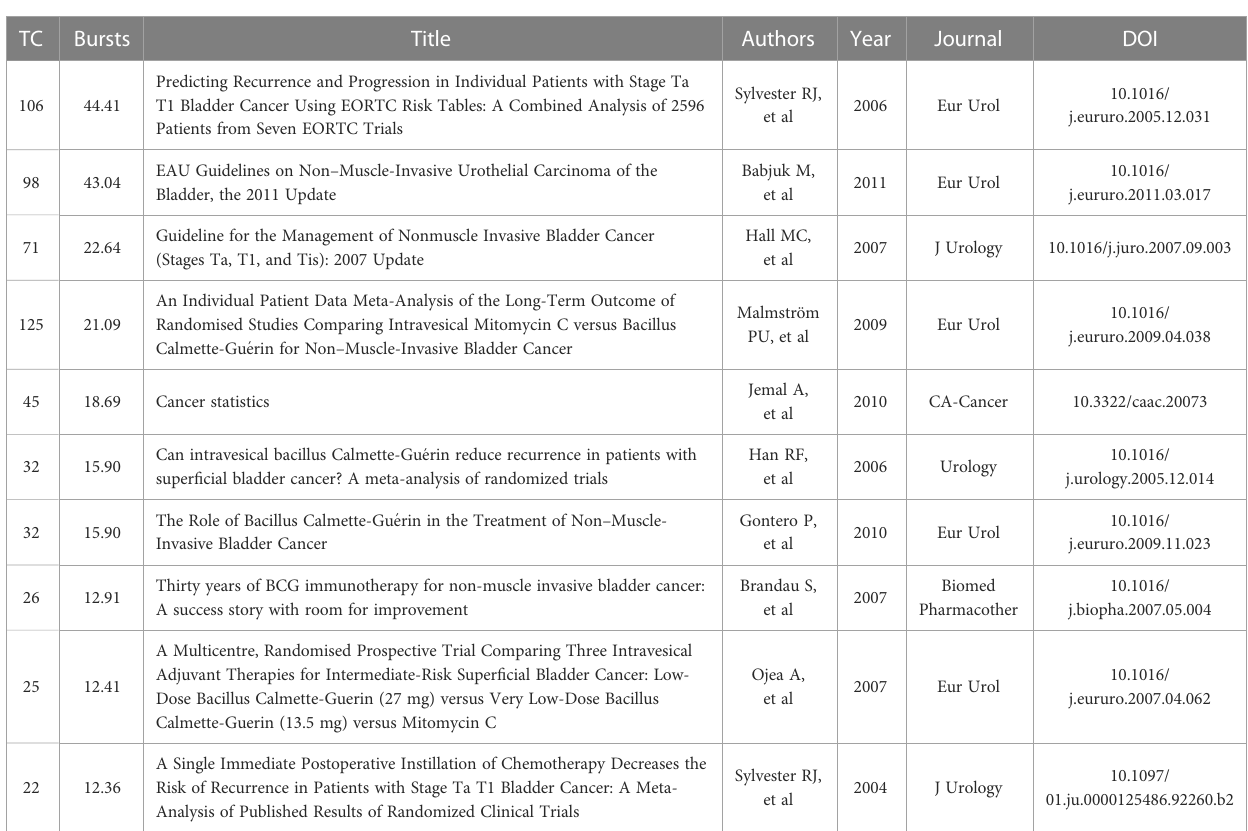
TABLE 5 The top 10 bursts of publications.